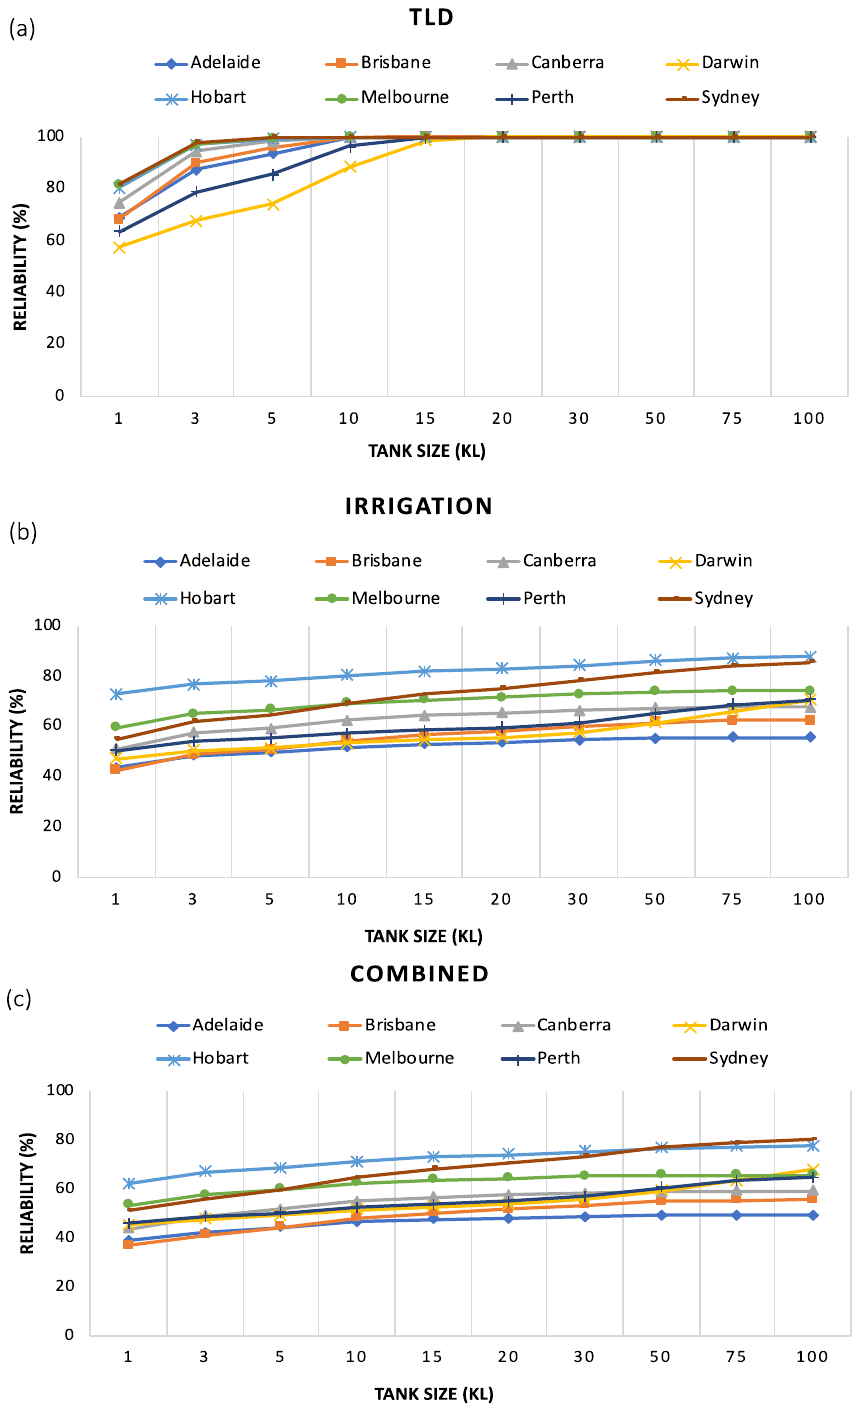
Figure 3. Reliability of rainwater tanks for TLD, irrigation and combined use ( a ) TLD use; ( b ) irrigation use; ( c ) combined use.